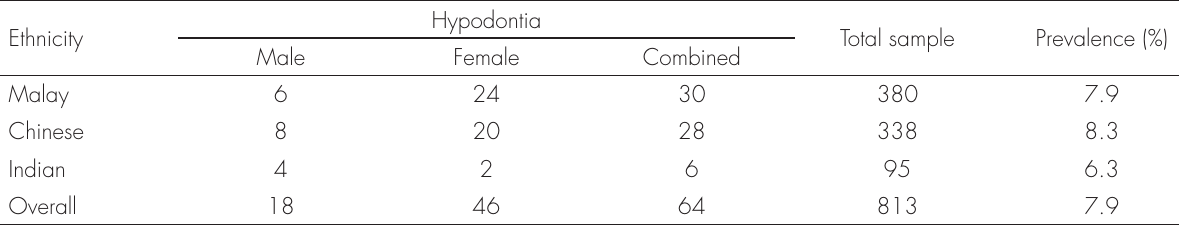
Table I. Distribution of recorded cases and prevalence of